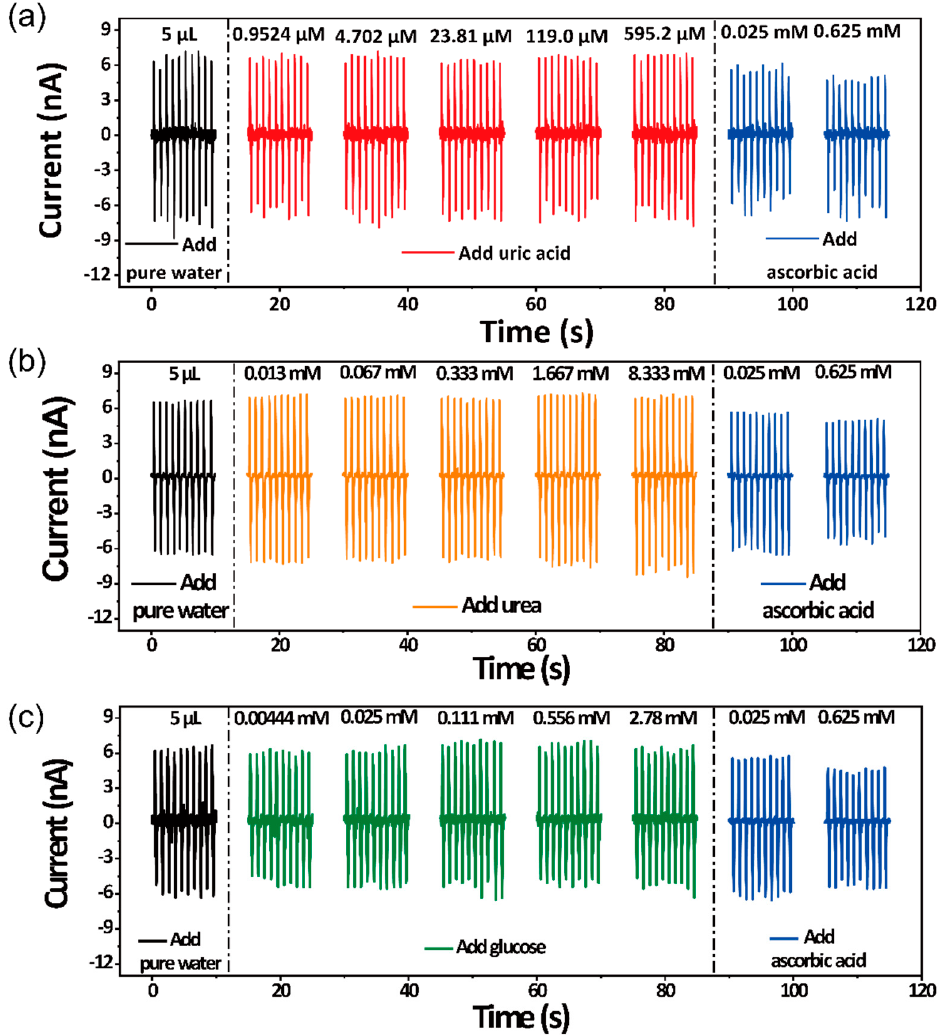
Figure 5. Control experiments. ( a ) Influence of different uric acid concentrations. ( b ) Influence of different glucose concentrations. ( c ) Influence of different urea concentrations.